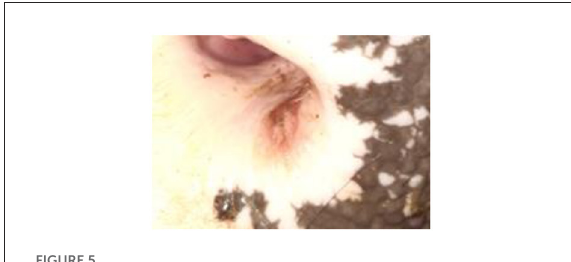
FIGURE5 Erosive lesions of the nasal mucosa of bull No 6, belonging to the IC group, on 28 dpi.